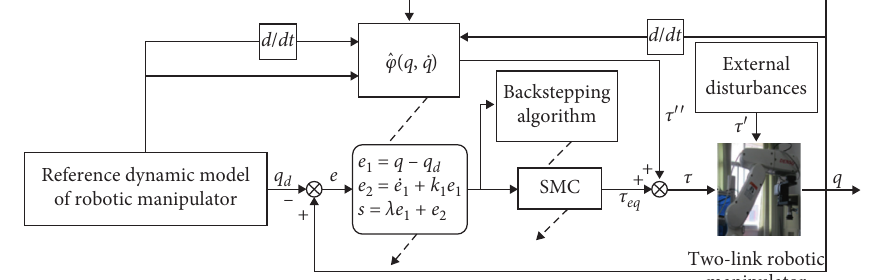
Figure 4: Schematic of the proposed control strategy.